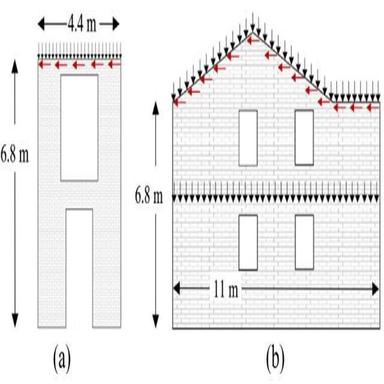
The geometries and loading conditions (black and red arrows corresponding to pre-compression and lateral loads, respectively) of (a) a single façade (b) a short-side wall. (For interpretation of the references to colour in this figure legend, the reader is referred to the web version of this article.)